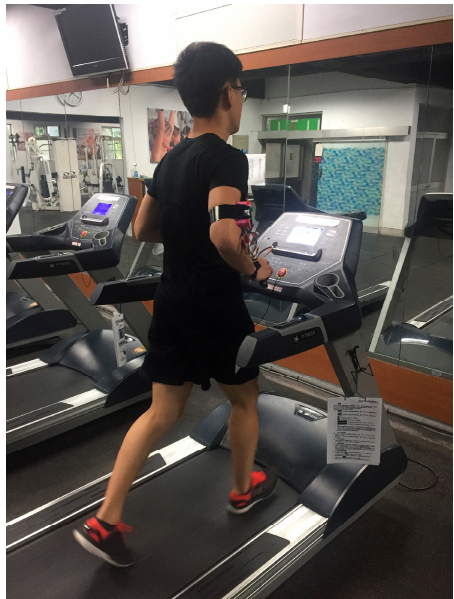
Figure 11. Experiment environment.